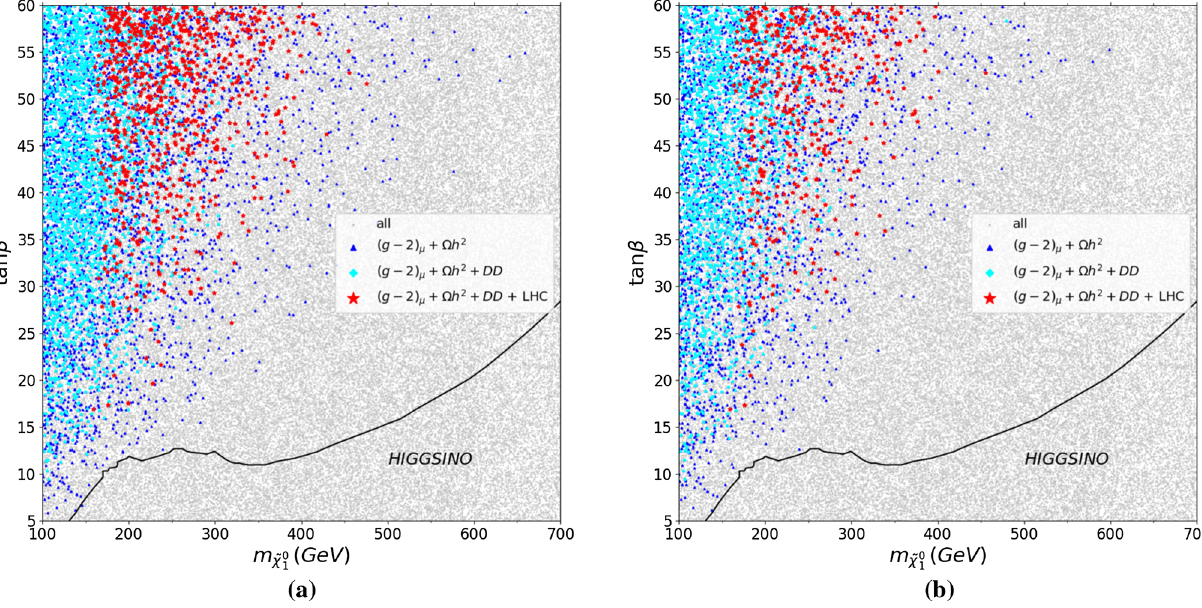
is as in Fig. 1. The black line indicates the current exclu- –tan β 1 sion bounds for heavy MSSM Higgs bosons at the LHC (see